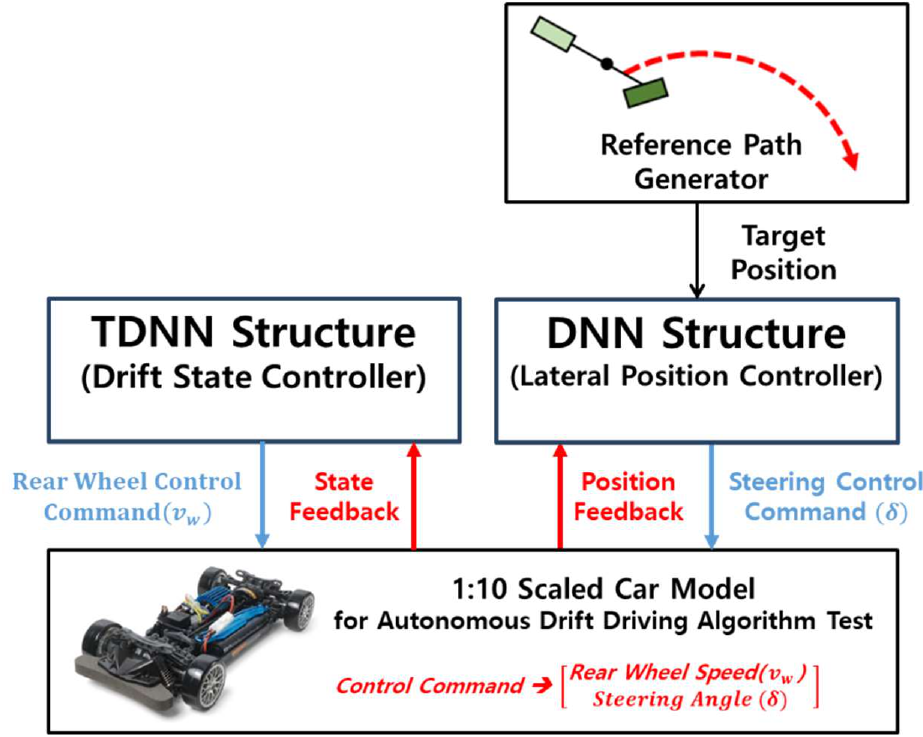
Figure 14. Neural-network-based drift control system.